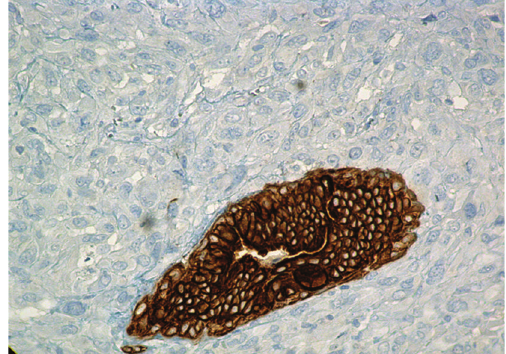
Figure 2: A remaining breast duct in the periphery of the tumor, immunoreactive to keratins AE1/AE3, surrounded by compactly arranged malignant cells, negative to keratins (DAB/Hematoxylin, × 400).